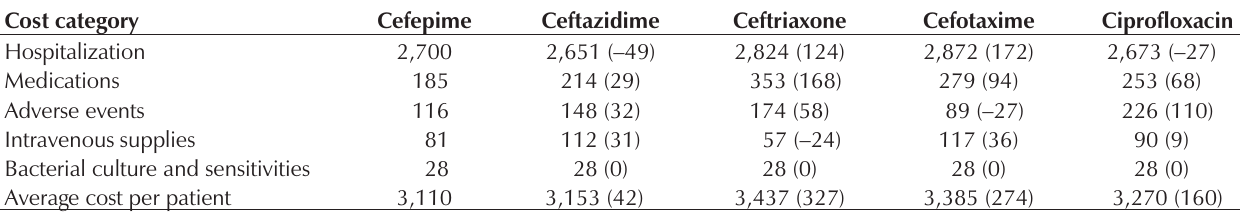
*Values in parentheses represent marginal costs compared with cefepime